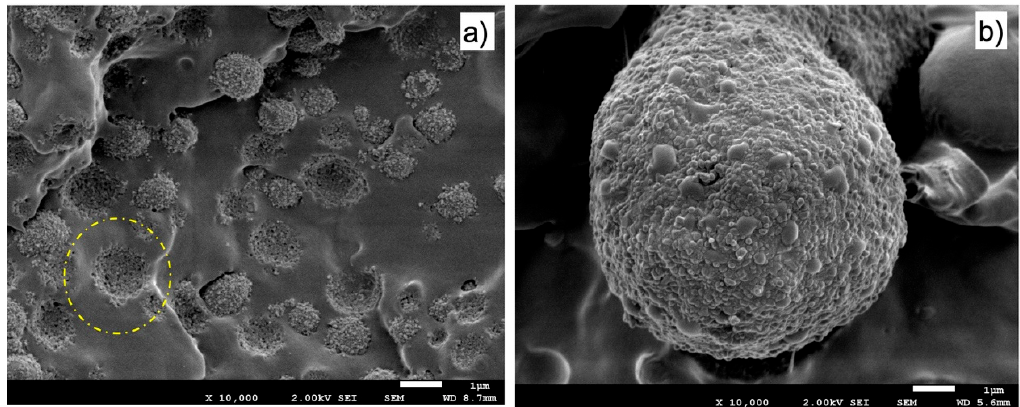
Figure 17. SEM micrographs from fracture surface of: PBNANO-hphoM ( a ) and PBNANO-hphi ( b ). The yellow circle highlights the TiO 2 nanoparticles that are left attached to the rPP matrix (“bed”) after extraction of a PET droplet.